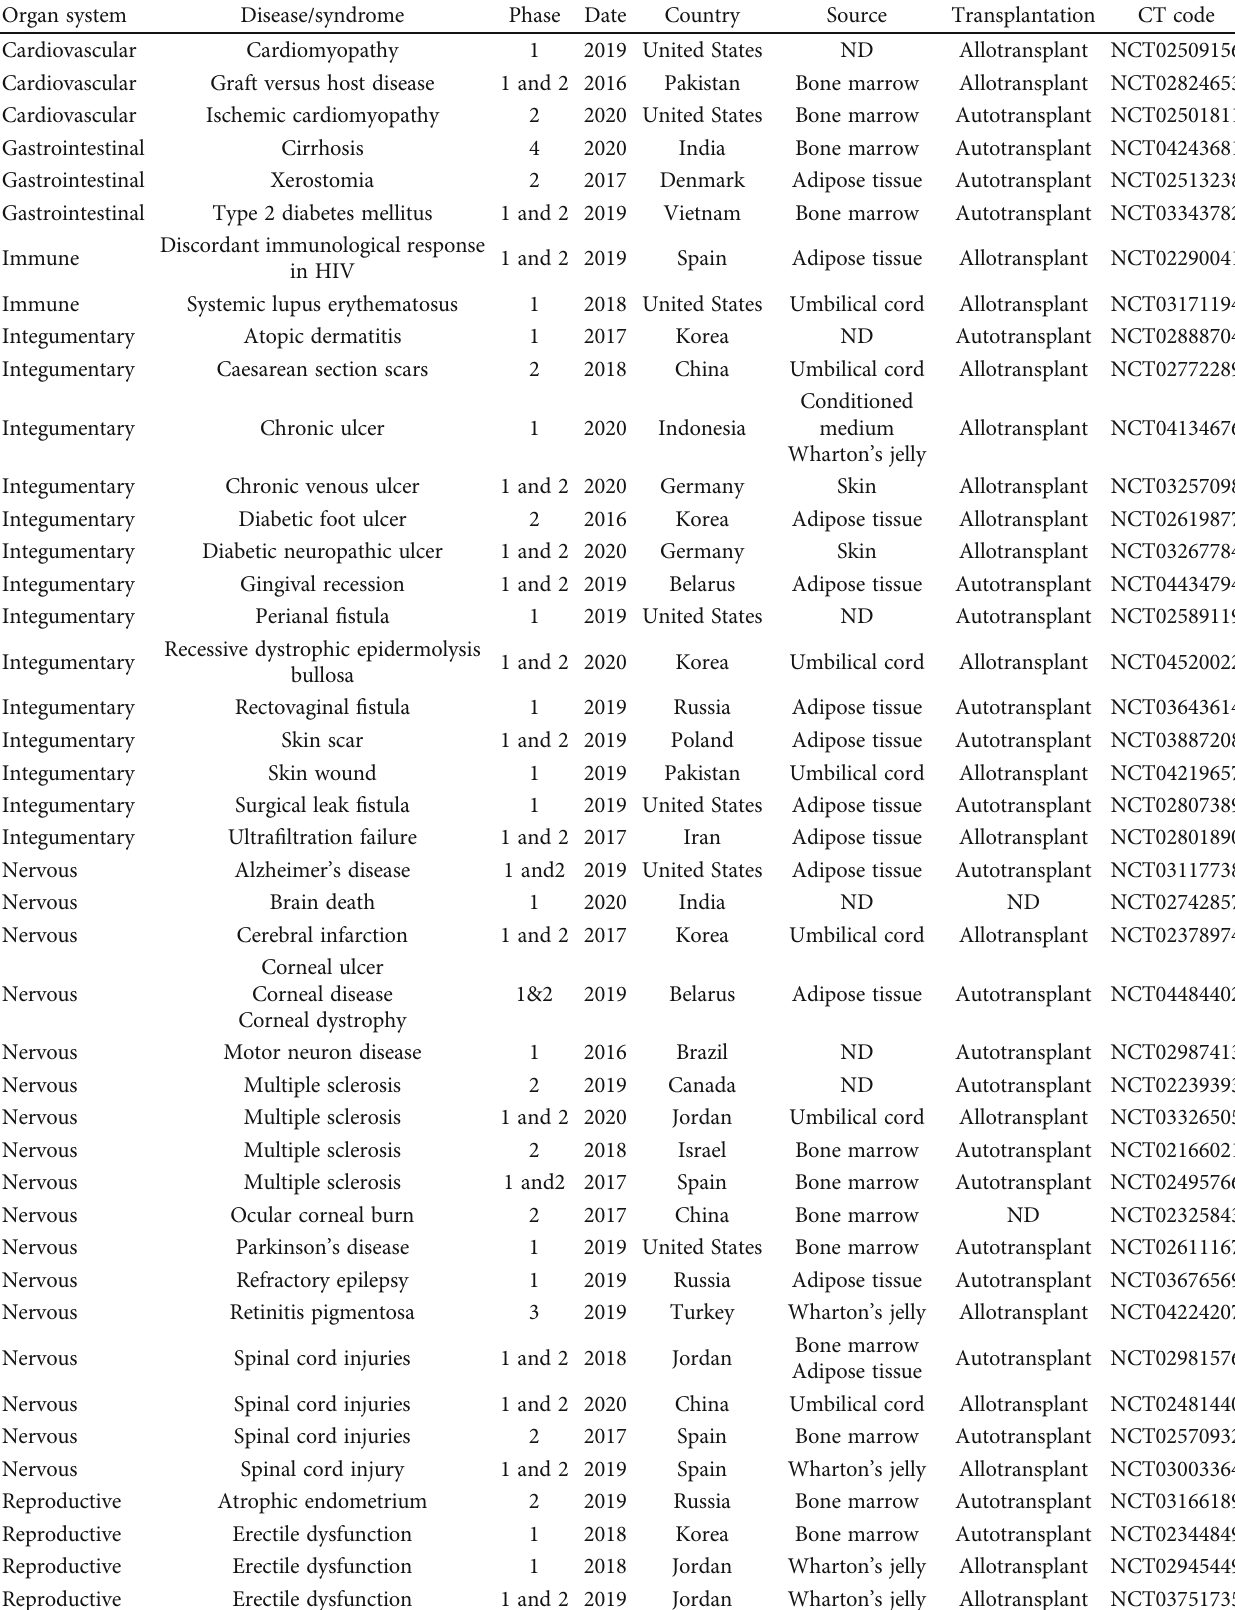
Table 1: Completed clinical trials on mesenchymal stromal cell-based therapy during 2016-2020 (U. S. National Library of